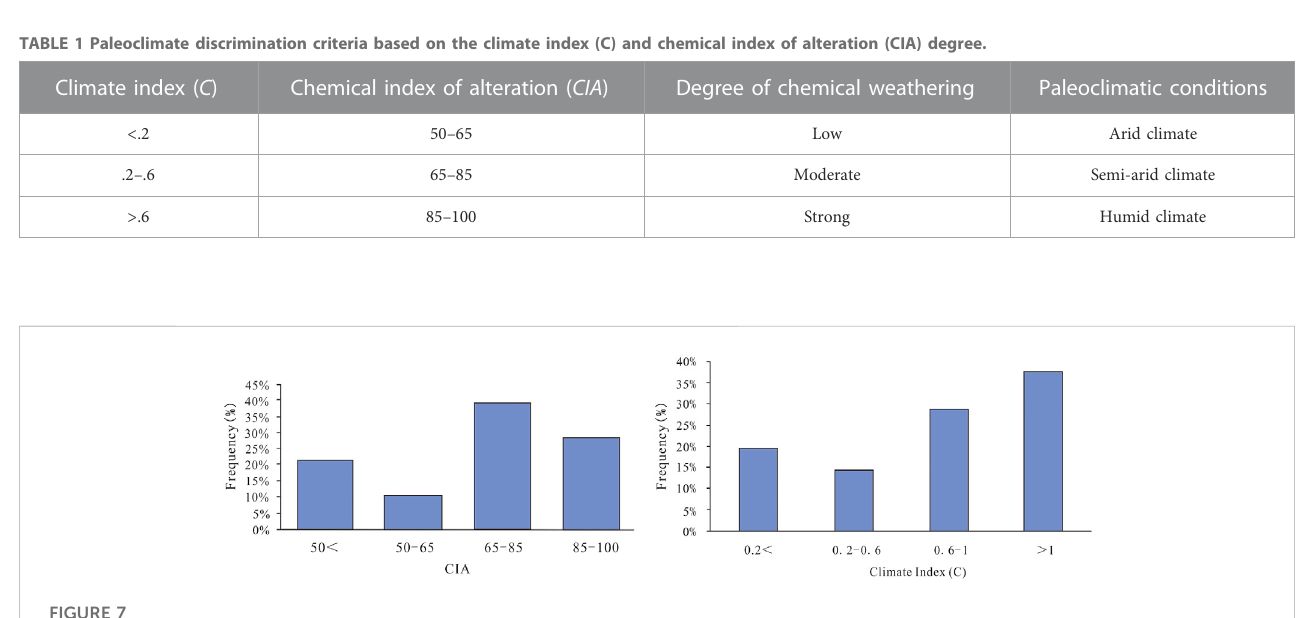
Frequency distribution of the chemical index of alteration ( CIA ) and climate index ( C ) for Well RA1.